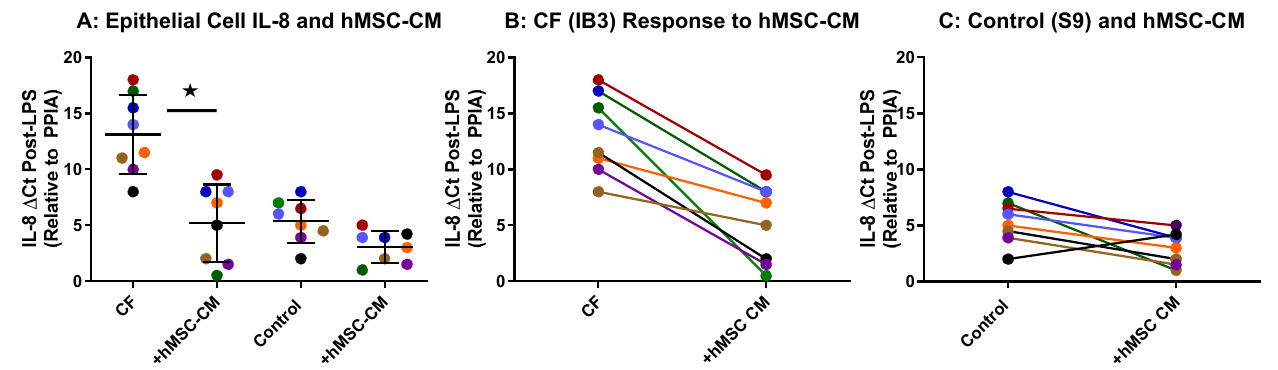
Figure 2 . hMSC Anti-Inflammatory Potency Screen on Transformed Human Airway Epithelial Cells . Each of the pre-GMP donor preparations (shown by a different color) were cultured in the absence of antibiotics for 72 h. The supernatants were screened for the ability to suppress the pro- duction of IL-8 from either CF (IB3) or non-CF (S9) airway epithelial cell lines stimulated with LPS (10 µg/mL) ( A ). Evaluating each hMSC-CM individually, the CFTR-deficient cell line ( B , IB3: n = 8) and control ( C , S9: n = 8) were analyzed. Consistent with previous studies, the hMSCs significantly decreased IL-8 gene expression (star designates p < 0.05), with each hMSC condition medium having a unique anti-inflammatory potency.